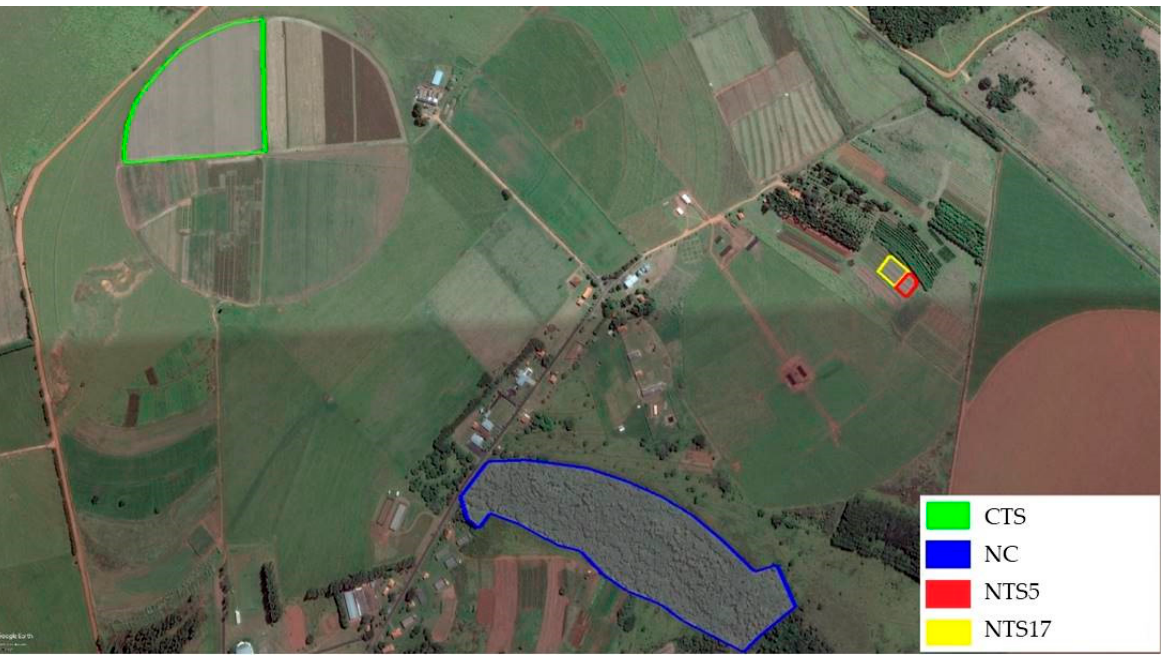
Figure 1. Areas studied with their respective demarcated perimeters. Source: Google earth (2023). The Native Cerrado (NC) area is located close to the experimental areas and has been undergoing a natural regeneration process for over twenty years. The region’s climate is classified as Aw [29], with a rainy season in summer and